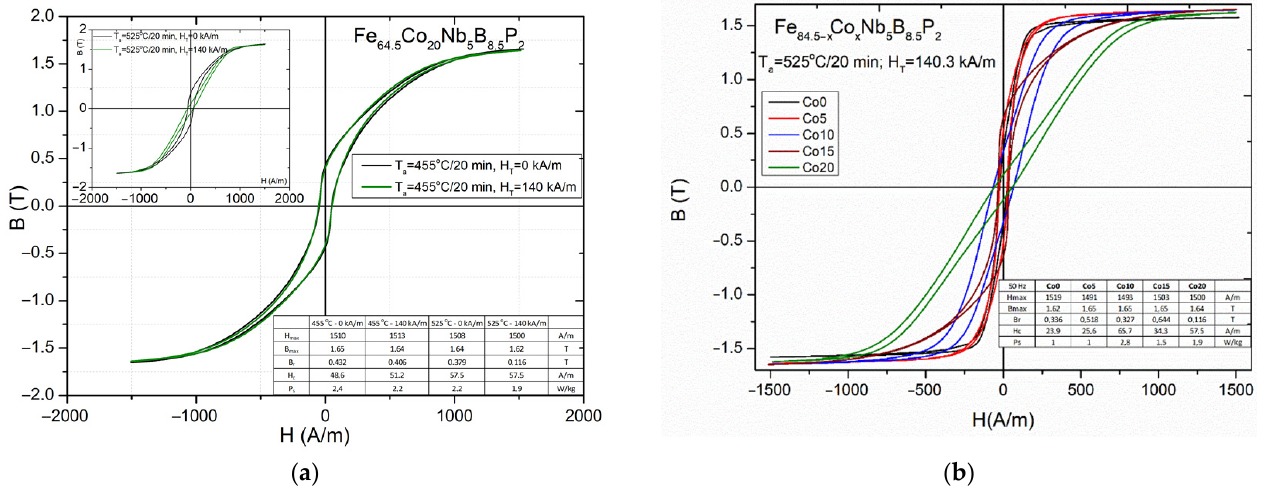
Figure 12. ( a ) Hysteresis loops for a Fe 64.5 Co 20 Nb 5 B 8.5 P 2 core after annealing at 455 °C without magnetic field (black) and in presence of a transverse magnetic field 140 kA/m (green) and on insert after annealing at 525 °C without magnetic field (black) and in presence of a transverse magnetic field 140 kA/m (green); ( b ) Hysteresis loops for Fe 84.5 − x Co x Nb 5 B 8.5 P 2 ( x = 0–20 at.%) cores annealed at 525 ° C in a presence of transverse magnetic field 140 kA/m.